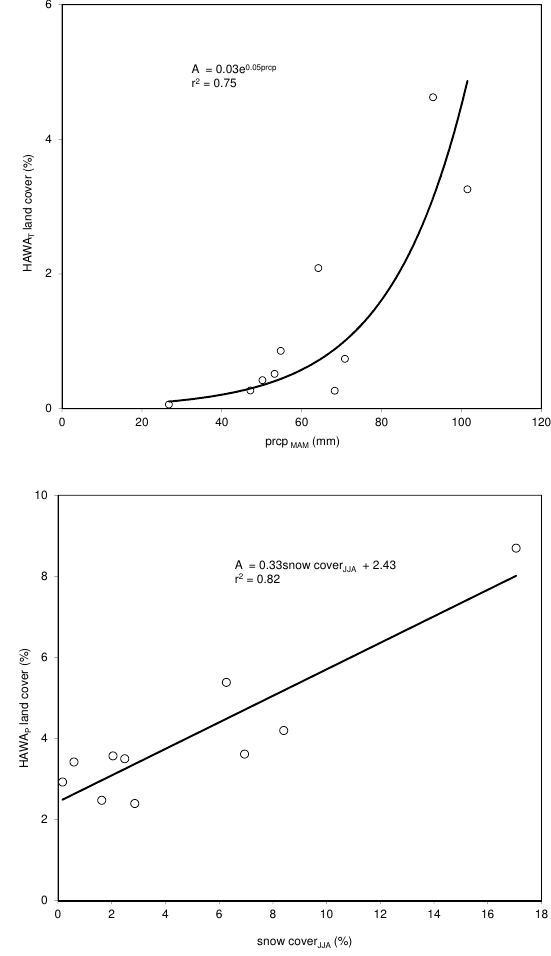
Fig. 11. Relation between prcp MAM and HAWA T land cover (top) and snowcover JJA and HAWA P land cover (bottom) of 2000 to